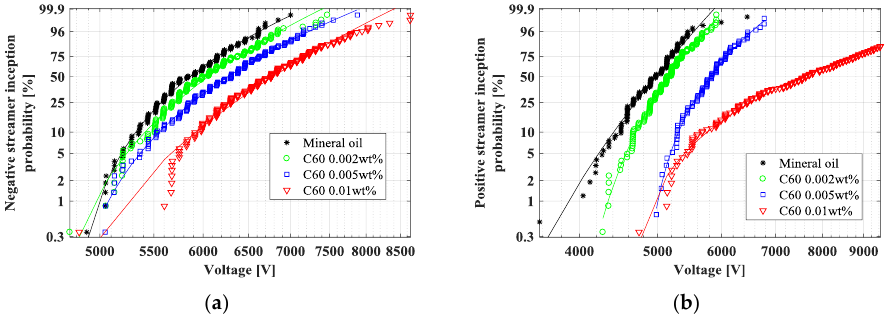
Figure 9. Streamer inception cumulative probability of C 60 nanofluids at different mass concentrations under ( a ) negative and ( b ) positive polarity. The reference data of mineral oil is added for sake of comparison. The corresponding fitting Weibull functions are shown as solid lines.